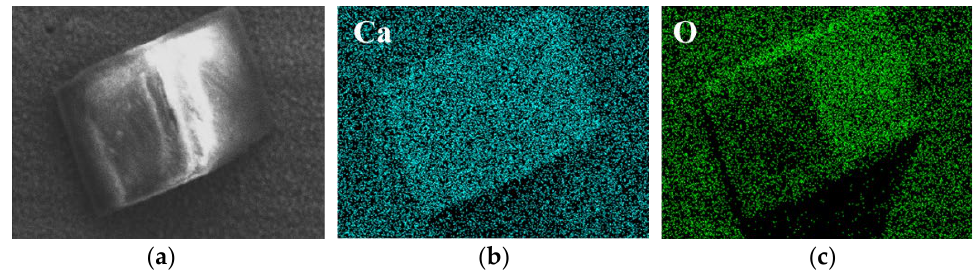
Figure 9. Elements distributions of the surface of tungsten in ultrapure water for 60 days. (( a ) is the SEM image; ( b ) is the mapping of O element.).